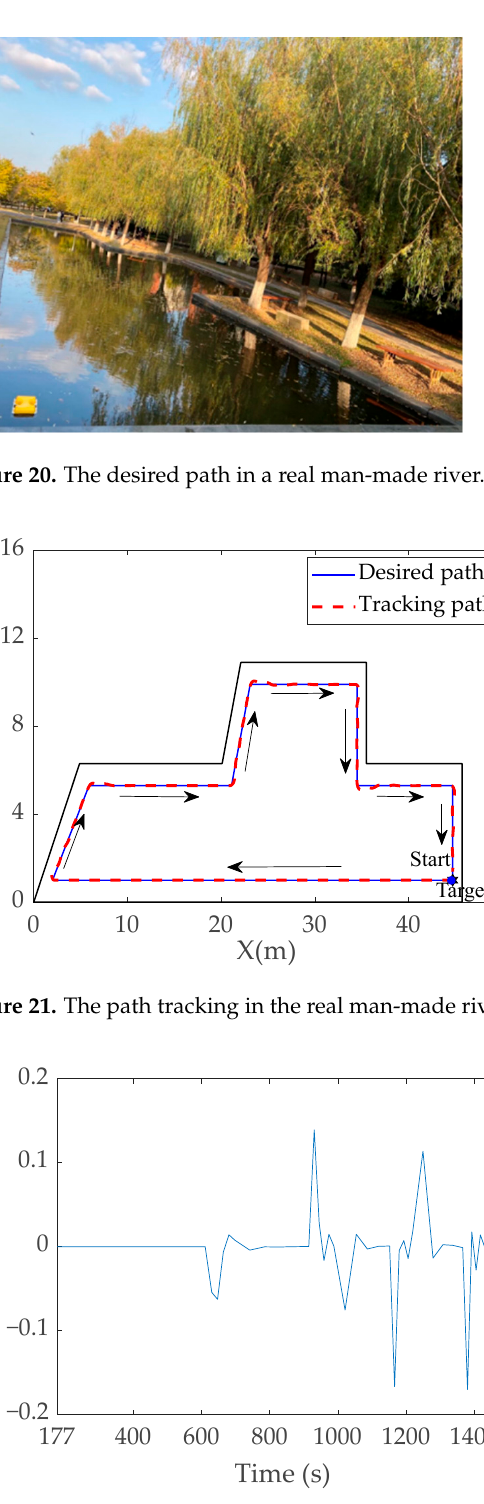
Figure 23. Cross-track heading angle error for the AUV. 6. Conclusions AUV path tracking is important to realize for AUV application in numerous missions for the exploration of marine resources. In this paper, a fuzzy controller was designed with multiple performance optimizations to complete path tracking. Based on the estab- lished AUV kinematic and dynamic models, we selected the path length, smoothness and cross-track position error as the objective functions of the optimization problem for the fuzzy controller. The PSO algorithm was used to optimize the membership function. We gave the straight line, sine curve, half-moon shape, Archimedean spiral, and practical paths to test the fuzzy controller’s performance for path tracking. The test results showed that the AUV effectively tracked the desired path using the proposed algorithm. Com- pared to the traditional algorithm, the designed controller made the path-tracking system perform well with better tracking accuracy, better smoothness and a shorter length using the proposed algorithm. In the near future, we are interested in improving the path-tracking performance by incorporating salient features such as sliding mode control, deep reinforcement learning, and so on. Collaborative work on multiple AUVs is an important way to efficiently ac- complish these missions, of which the key factor is how to accurately track multiple paths. Therefore, providing a method for multiple AUV path tracking is also our next work. Author Contributions: Conceptualization, Q.T. and T.W.; methodology, Q.T.; software, T.W.; vali- dation, Q.T., Y.W., Y.S. and B.L.; formal analysis, Q.T.; investigation, Q.T. and T.W.; resources, Y.W.; data curation, Y.S.; writing—original draft preparation, Q.T.; writing—review and editing, Y.W.; visualization, Y.S.; supervision, B.L.; project administration, B.L.; funding acquisition, Y.W. All au- thors have read and agreed to the published version of the manuscript.